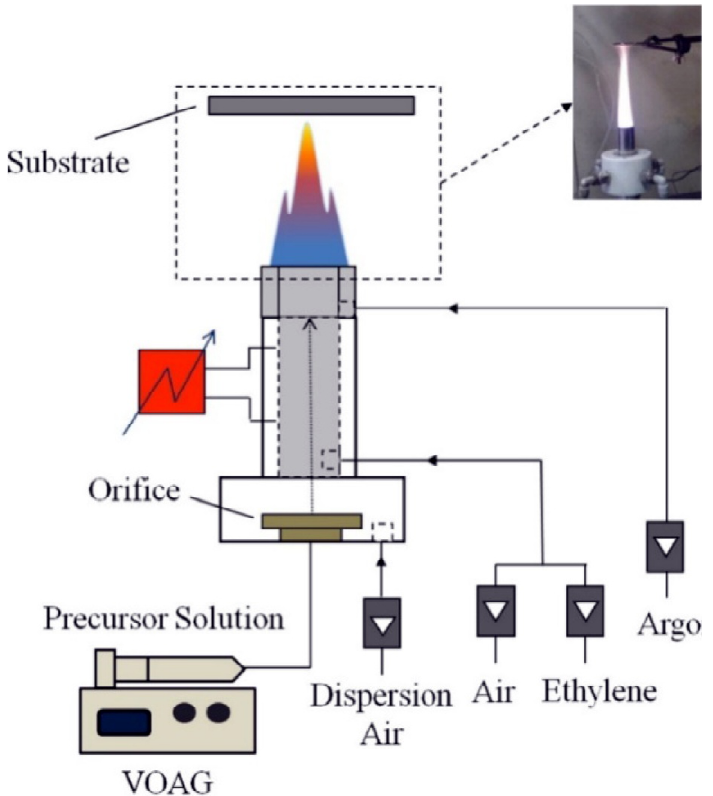
Fig. 4. Typical setup of aerosol flame synthesis